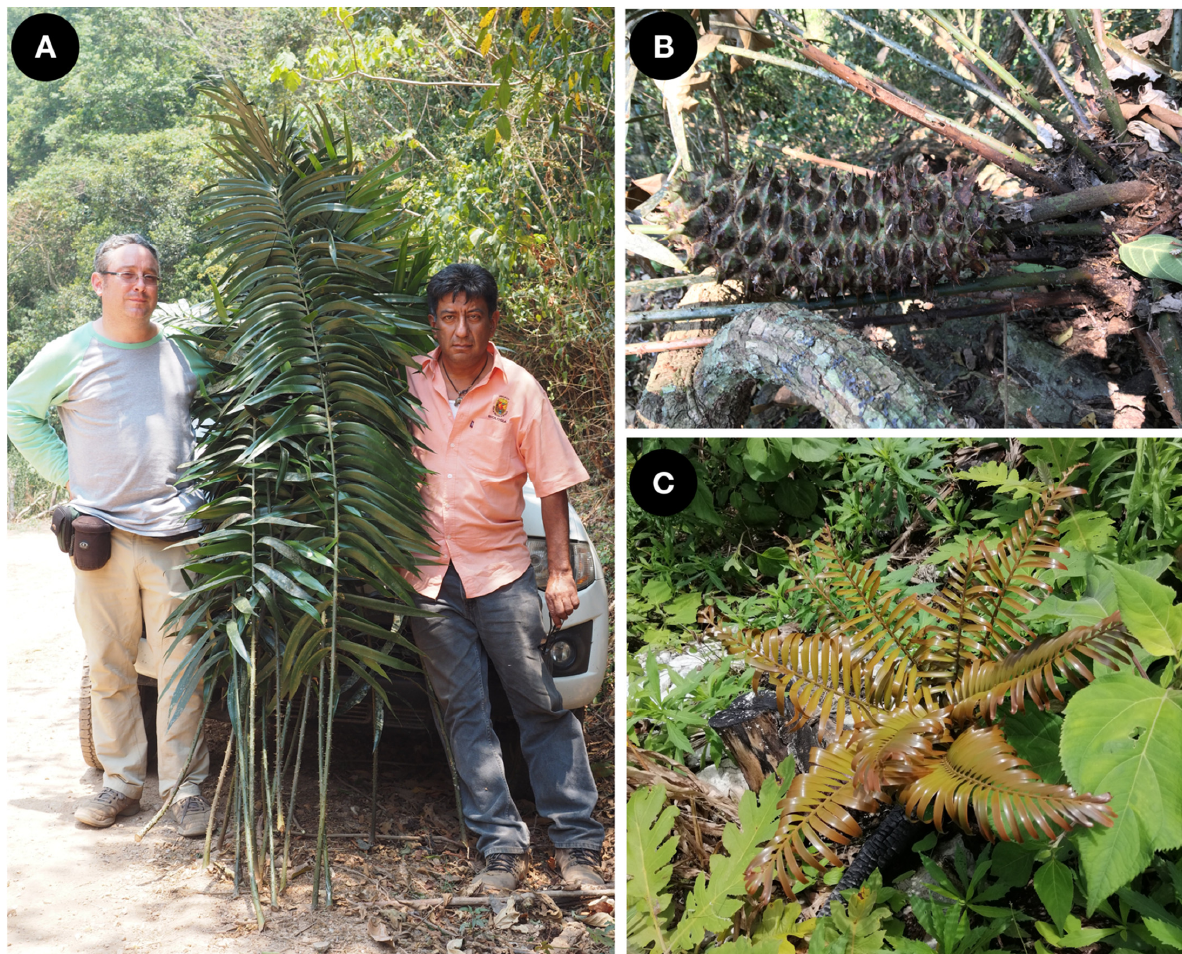
Figure 5. Some of the distinctive features of Ceratozamia schiblii . ( A ) Leaves are one of the longest and with the highest number of leaflet pairs among the species of the C. robusta species complex (left: M.C.; right, M.A.P.-F.). ( B ) Megastrobili (seed cones) are pendulous and peduncles long. ( C ) Emerging leaves are of brown color. Photo A by Cesar Daniel Coutiño Ovando. Photos B and C by Miguel Angel Pérez Farrera.